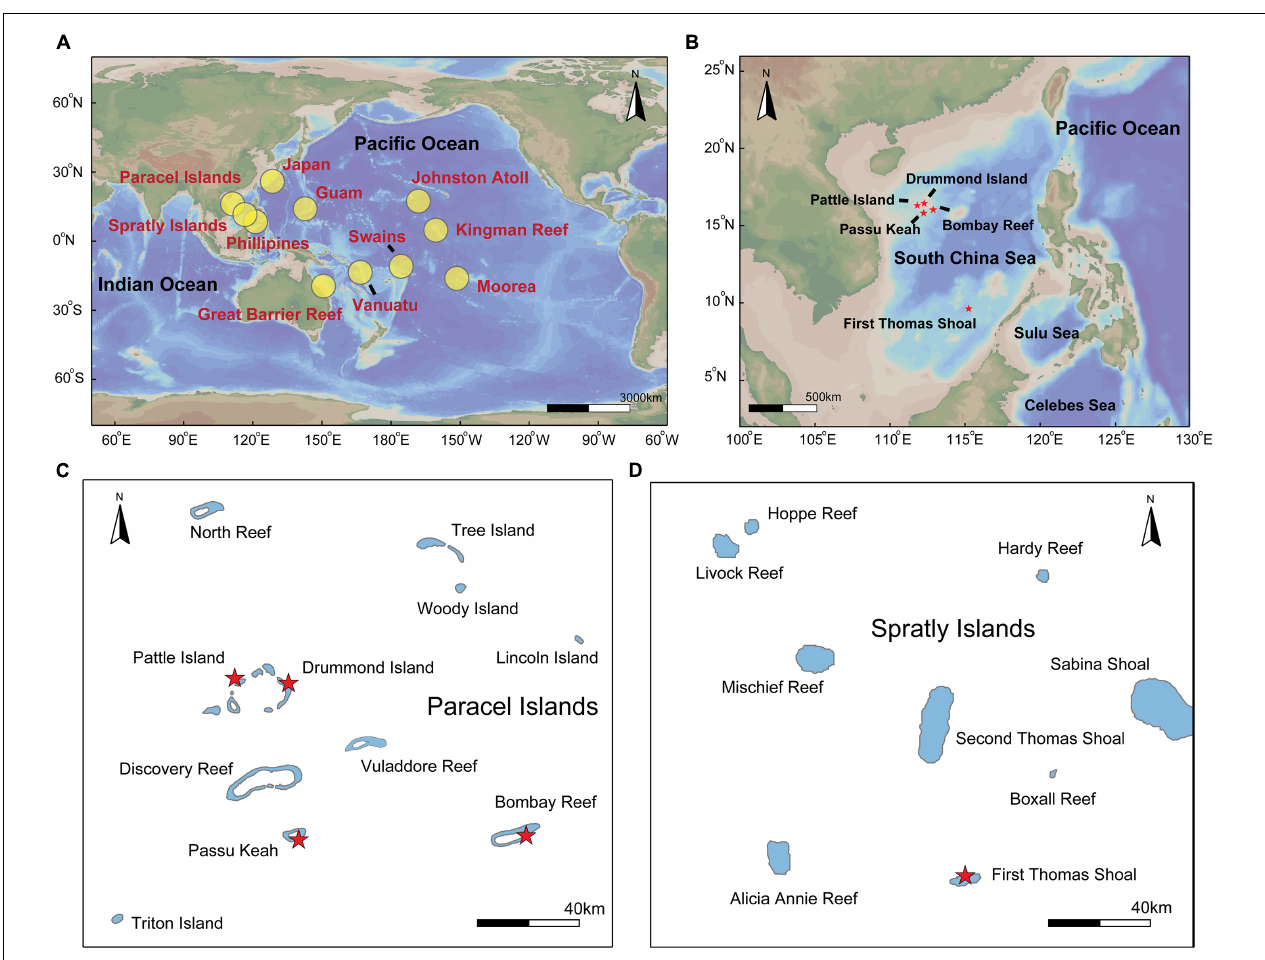
FIGURE 1 | Locations of crown-of-thorns starfish (COTS) sample collections in the Pacific Ocean and South China Sea (SCS). (A) Overview of study locations. Our sample areas which include the Paracel and Spratly Islands within the SCS. COTS microsatellite loci data was retrieved from the Western Pacific (Japan, Philippines, Great Barrier Reef, and Vanuatu), Pacific equatorial currents affected zone (Guam, Kingman Reef, and Swains) and Pacific insular atoll (Johnston Atoll and Moorea; Tusso et al., 2016). These locations were marked by red in the map. (B) The details of sampling locations in the SCS, (C) which including Pattle Island, Drummond Island, Bombay Reef and Passu Keah in the Paracel Islands, (D) also including First Thomas Shoal in Spratly